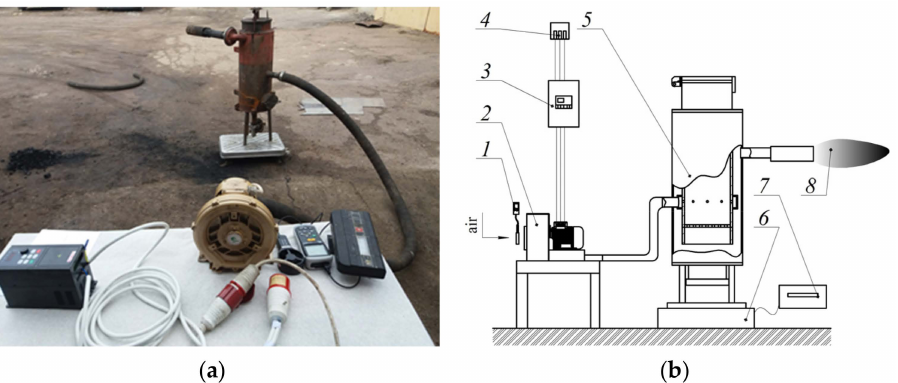
Figure 1. General view ( a ) and schematic diagram ( b ) of an experimental facility: 1—anemometer Ten- mars TM-402; 2—blower Goorui GHBH-0D5-34-1R2; 3—frequency converter Hitachi-3G3JX-A4075- EF; 4—power supply 0.4 kW; 5—downdraft gasifier; 6—scales; 7—scales indicator; 8—generator gas